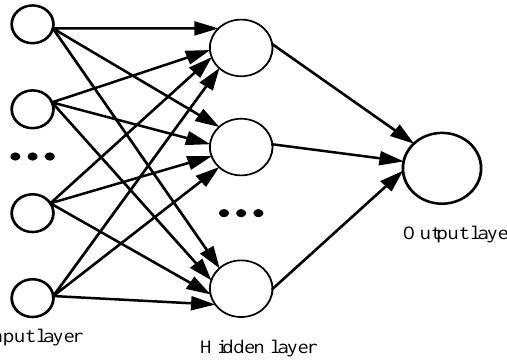
Figure 4. Typical neural network model structure